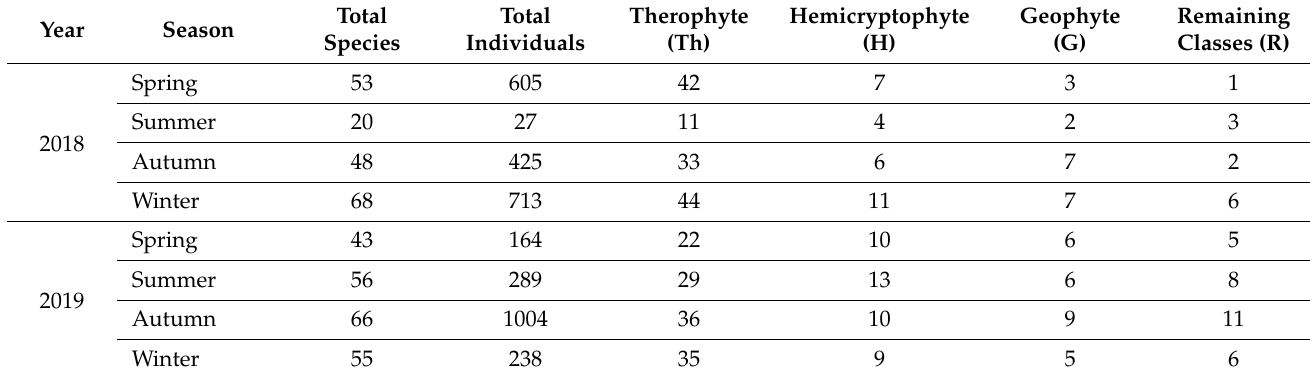
Table 5. Distribution of total species and individuals, as well as the ranking of the three more representative life forms in the QV agrosystem. Species were also grouped according to Raunkiaer’s Life Form classification